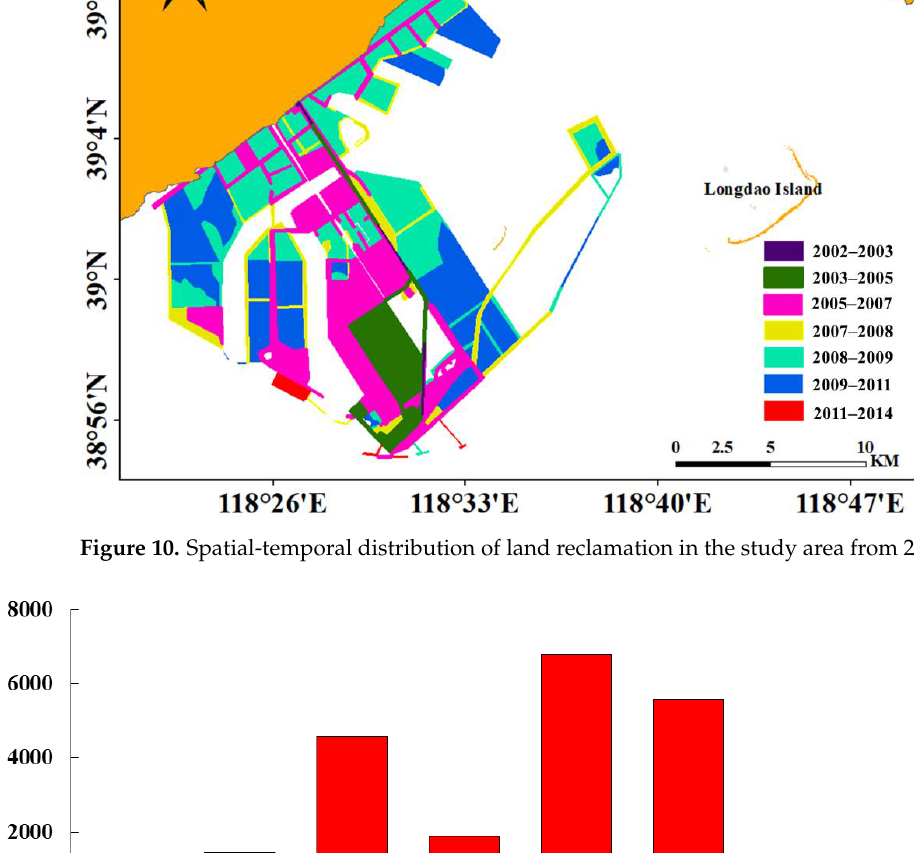
Figure 10. Spatial-temporal distribution of land reclamation in the study area from 2002 to 2014.